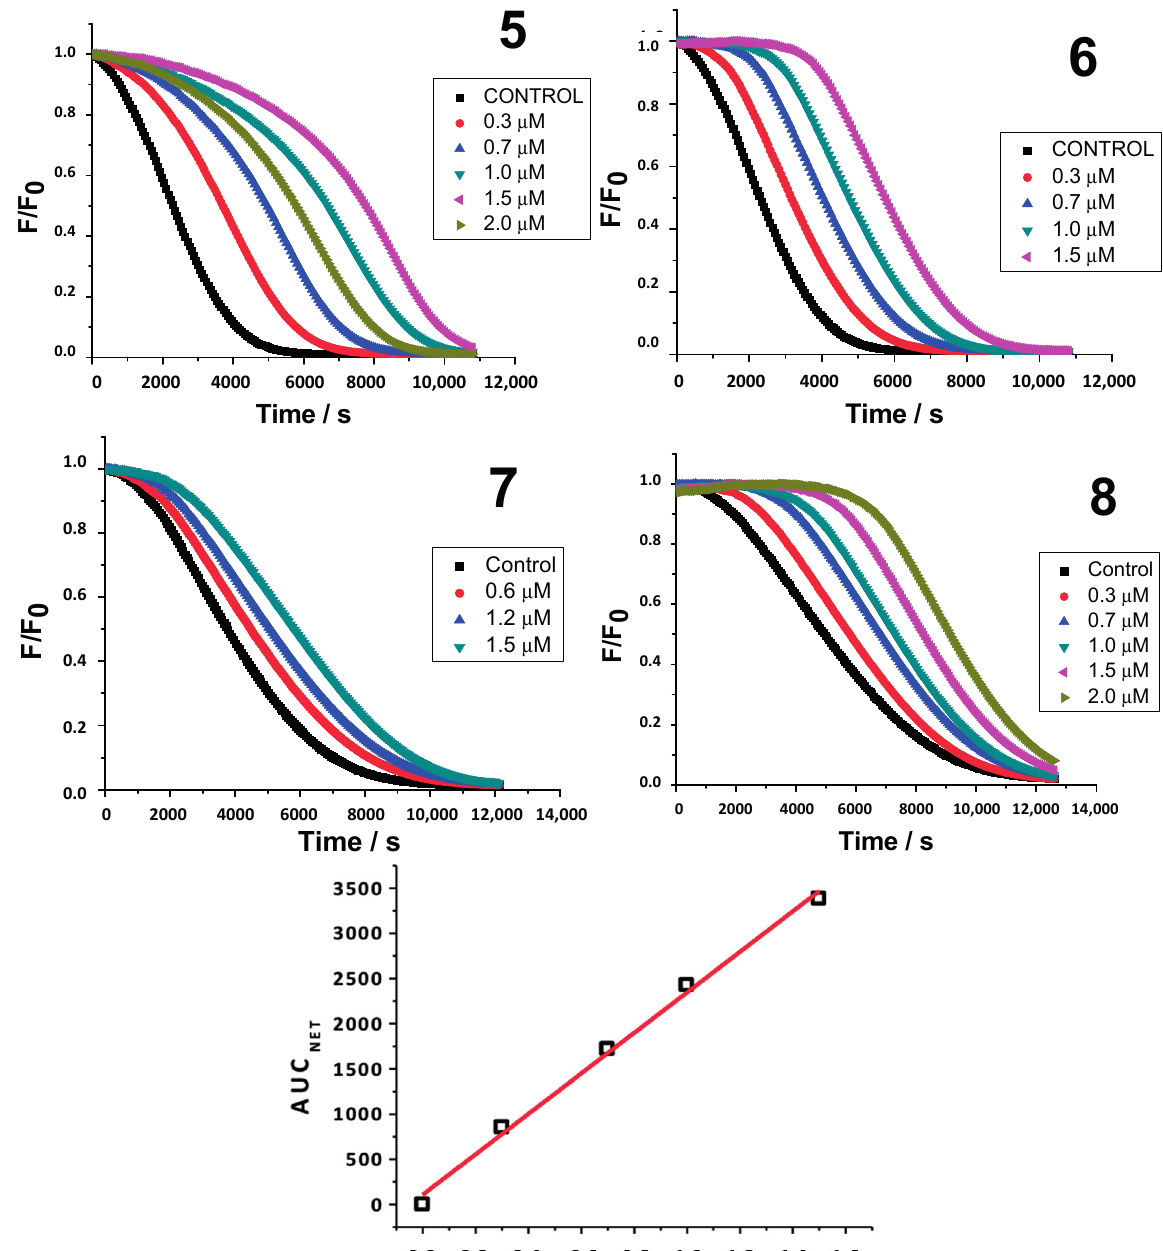
Figure 2. Kinetic profiles of FL consumption AAPH-mediated in presence of compounds 5 – 8 . F 0 is the fluorescence in absence of the compound and F the fluorescence in presence of the compound. Last graphic: AUC NET versus concentration of compound 6